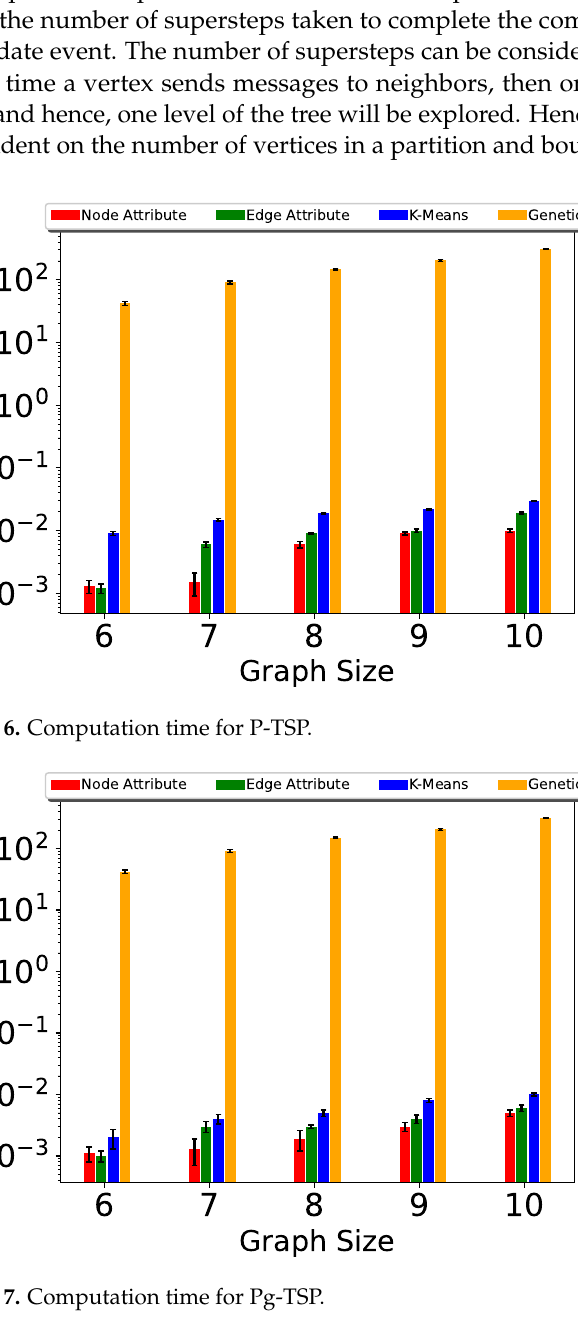
Figure 7. Computation time for